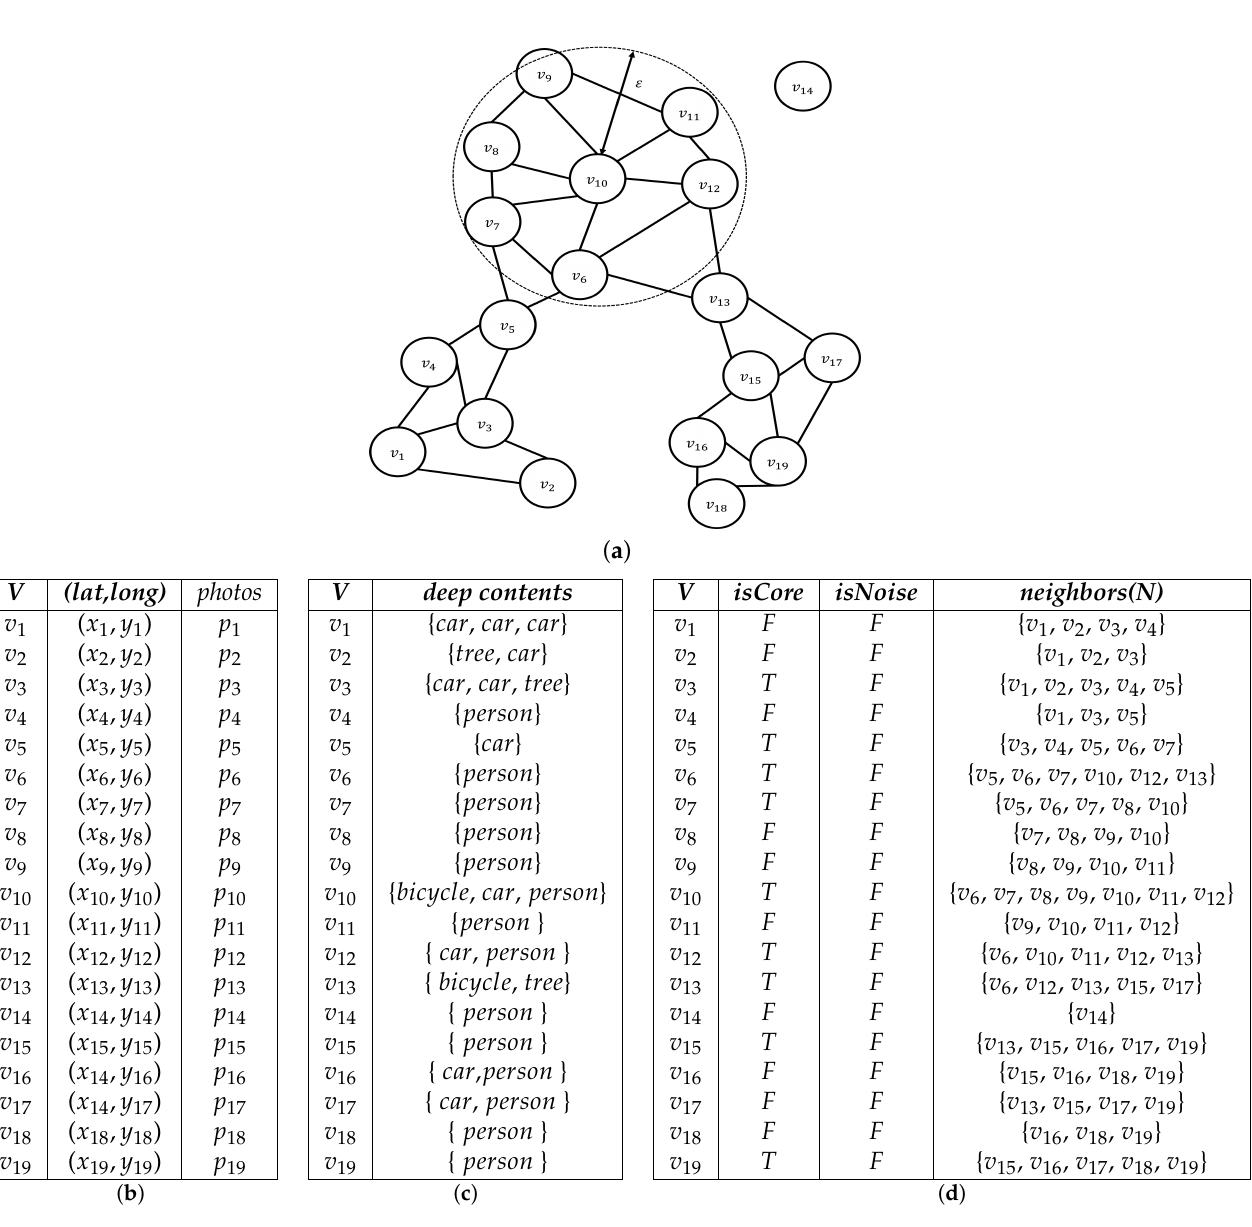
Figure 2. Example of a nearest neighbor graph. ( a ) ε -nearest neighbors graph; ( b ) geo-tagged photos table, P ; ( c ) real deep contents table; ( d ) initial nearest neighbor graph,